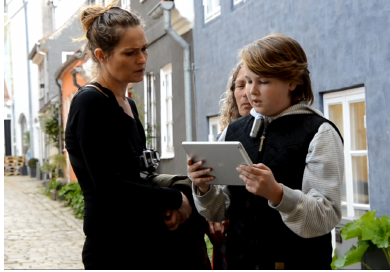
Figure 6. All participantsattendingto the iPad, tryingto solve the riddle